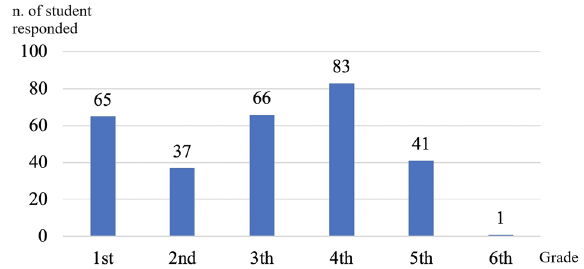
Figure 1: The number of the respondent students in regard to their